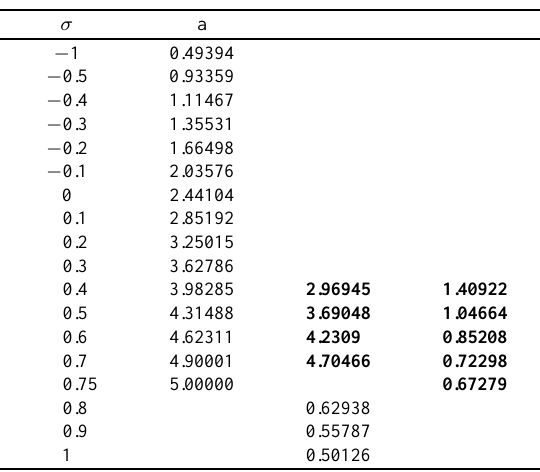
Table 1 Frequency response data simulated by